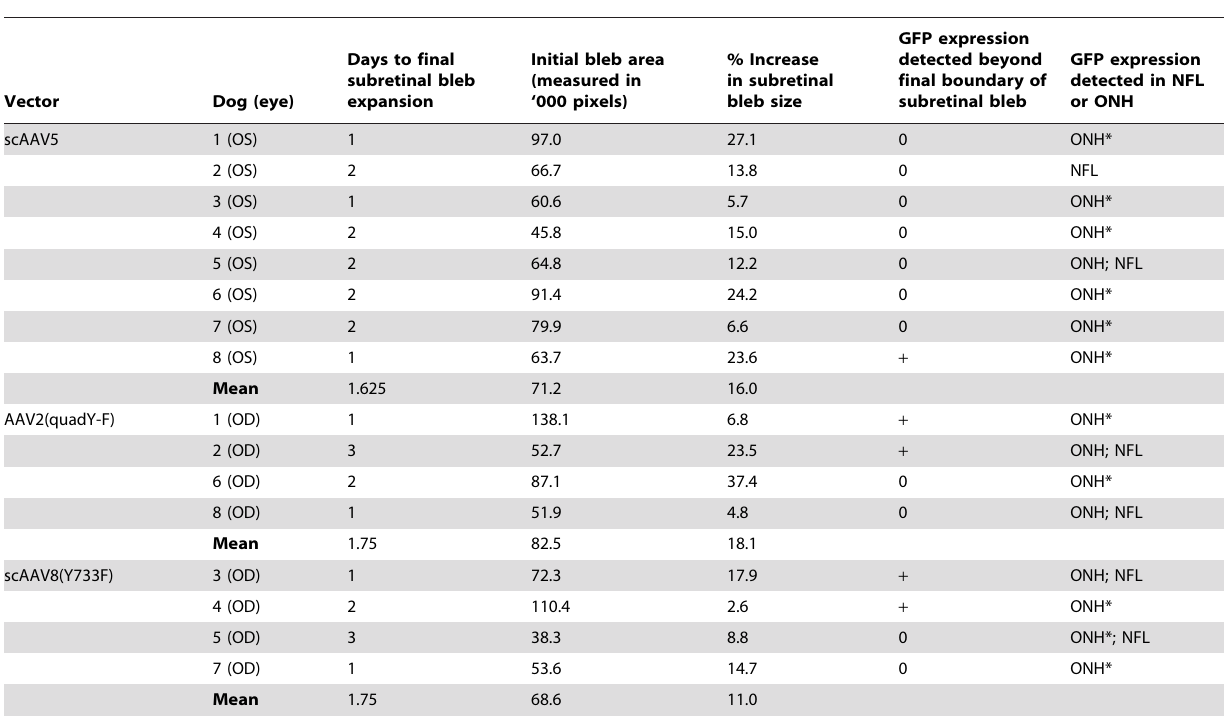
Table 1. Results of spread of injection bleb and extent of final GFP expression.